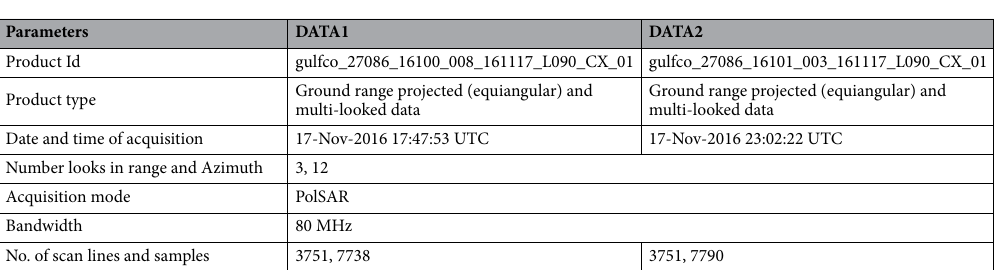
Table 2. Dataset details and